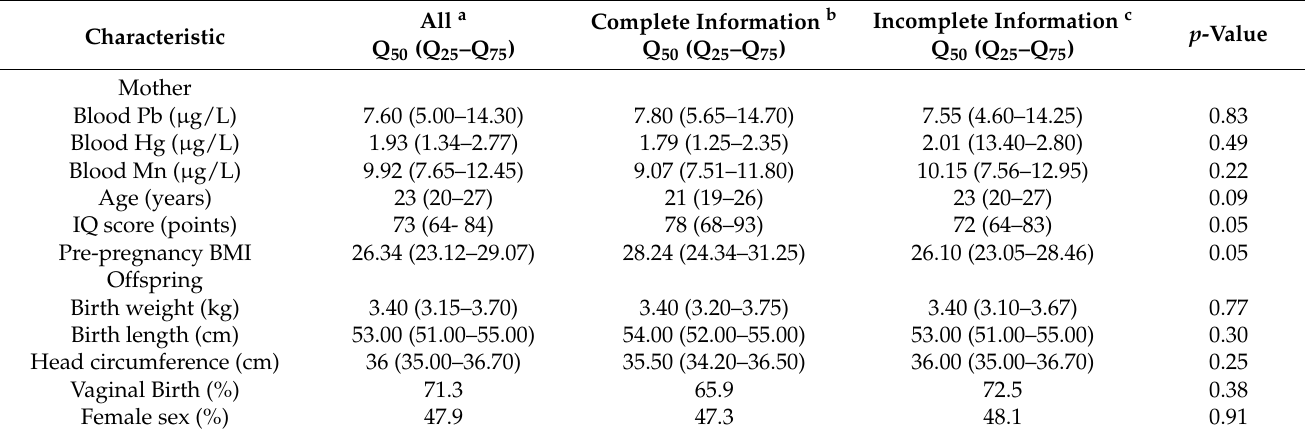
Table 1. Study subjects’ main characteristics: comparison of medians and interquartile ranges according to completion of study